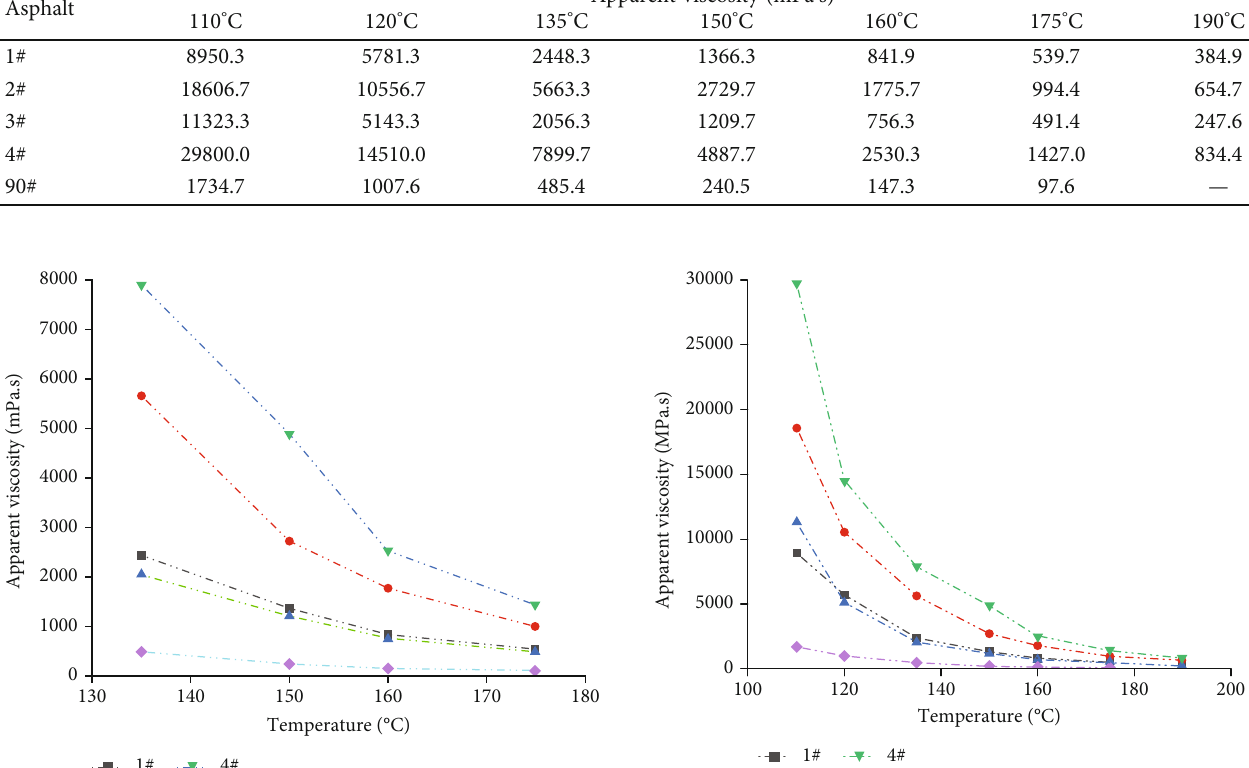
Table 4: Test results of the apparent viscosity of tire rubber powder-modi fi ed asphalt. Asphalt